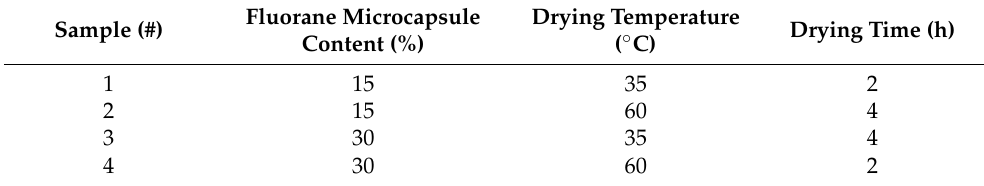
Table 1. Arrangement of the orthogonal